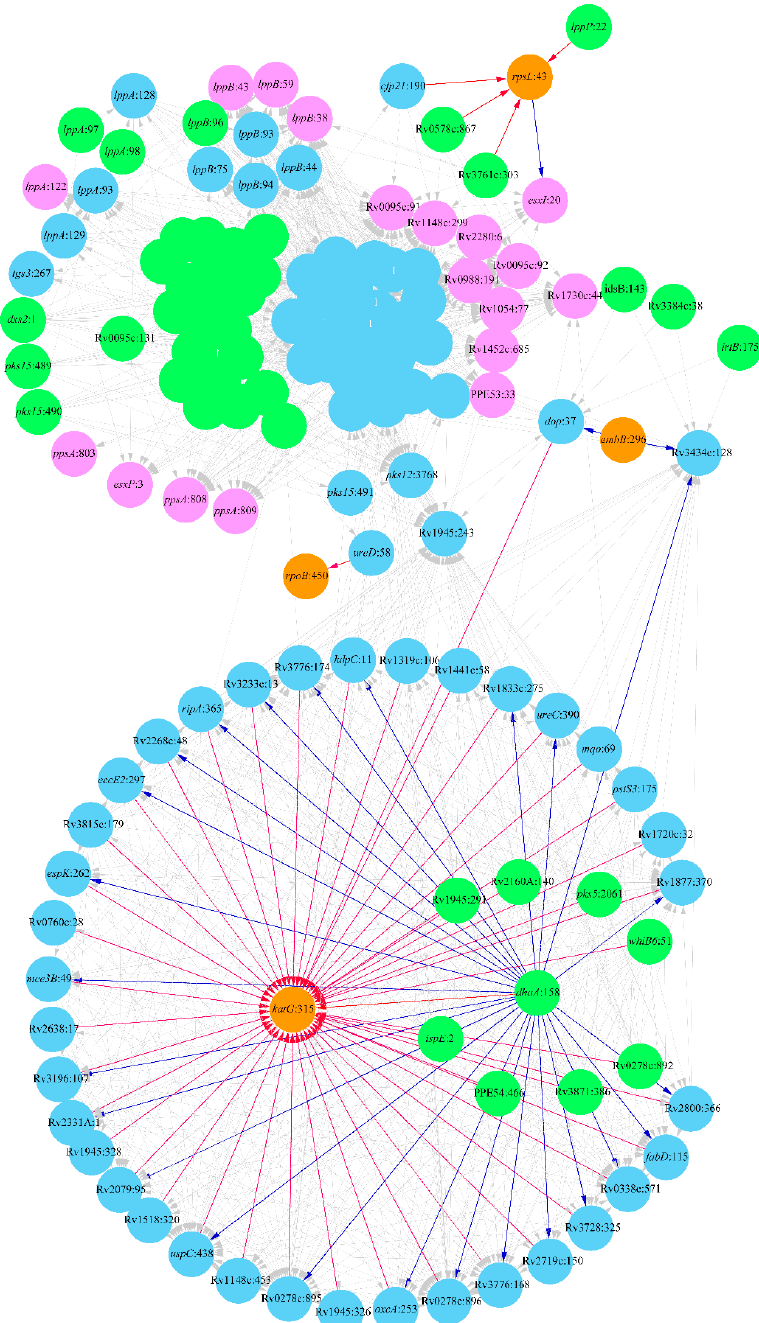
Figure 2. Network of DR-associated mutations in the clade Beijing (Lineage 2). Polymorphic loci are shown as nodes titled by the respective gene name and the polymorphic codon number following the colon. Mutations known to cause DR are depicted by an orange color. Nodes linked exclusively by outgoing edges (prerequisite mutations) are shown in green, and those linked exclusively by incoming edges (final and compensatory mutations) are shown in pink, while intermediate mutations are shown in blue. Arrows show the relations between prerequisite and subordinate mutations, which in the case of direct association with the known DR mutations are highlighted by red and blue colors, respectively. The mutations linked to more than 20 subordinate mutations and having no prerequisite mutations were supposed as starting points of the DR evolution. They are depicted by a red stroke